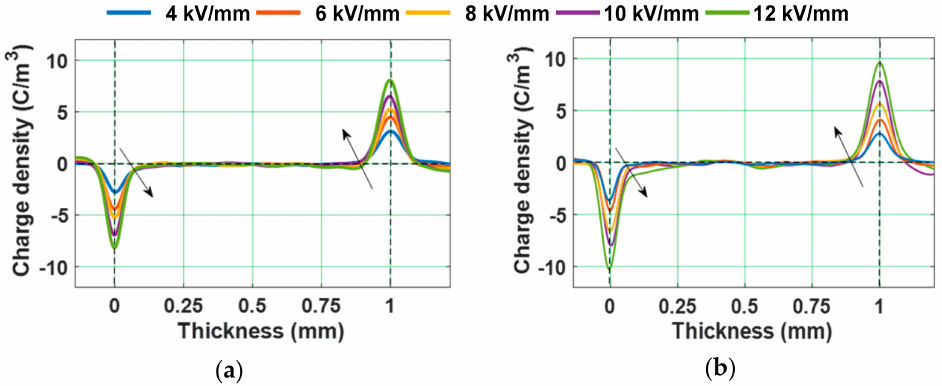
Figure 4. Variation in space charge density under different applied electric fields in ( a ) unaged and ( b ) 8 kGy gamma irradiated epoxy micro-nano composites [29].